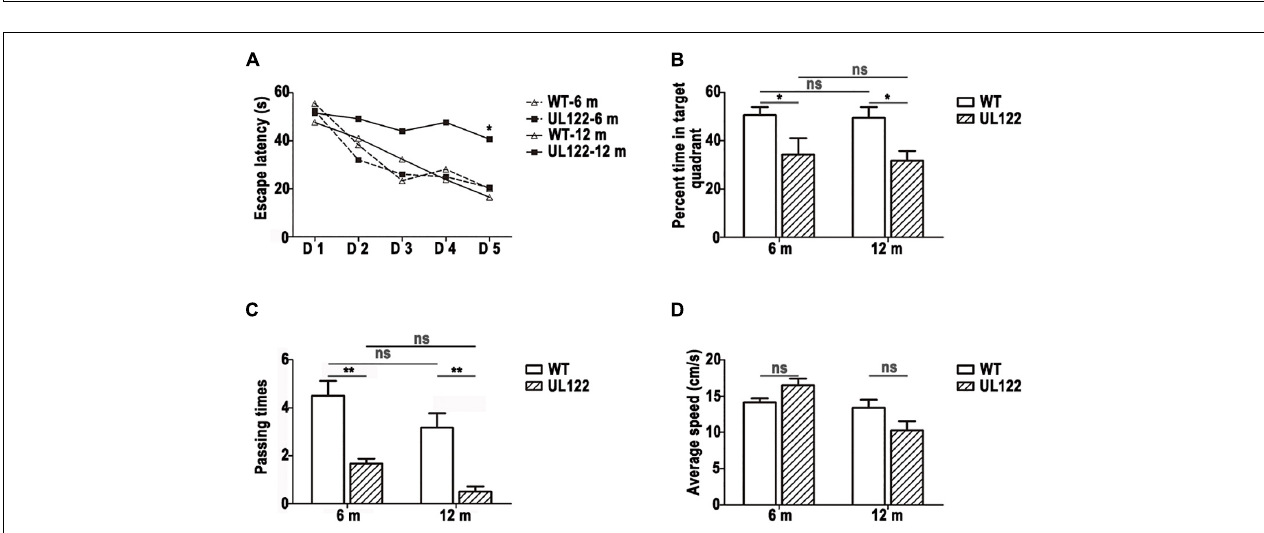
FIGURE 2 | The learning and memory ability of UL122 mice aged 6 and 12 months were tested in the MWM test (A–D) ; (A) The time of escaping latency. (B) Percentage of time in the target quadrant. (C) Times of passing through platform. (D) Average speed. Data were expressed as mean ± SEM( n = 6 for each group). Comparison (A) was made by analysis of variance of repeated measure and the comparison of the rest was analyzed with two-way analysis of variance (ANOVA) (* P < 0.05, ** P < 0.01 vs. the control).